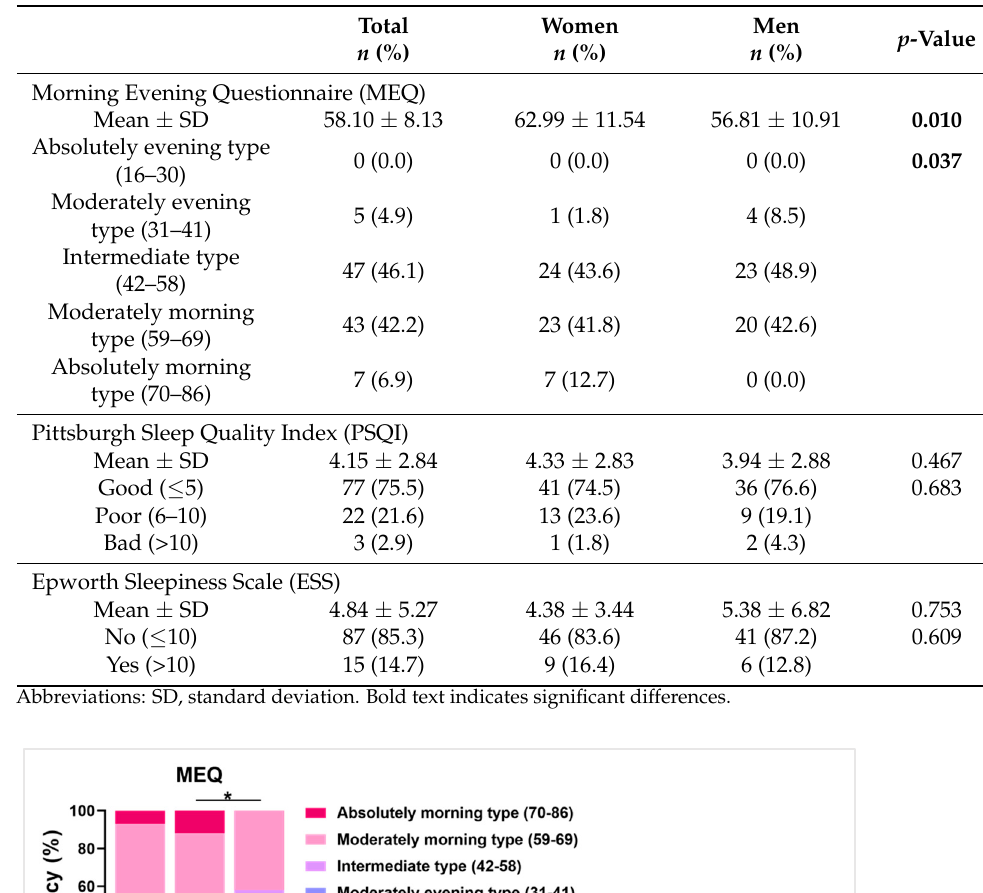
Table 4. Psychodiagnostics protocol results concerning overall sleep quality evaluation.